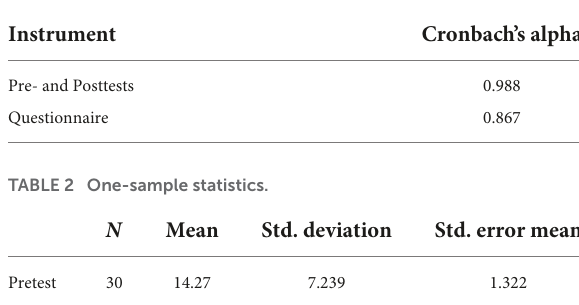
TABLE 1 Reliability statistics of research instruments.